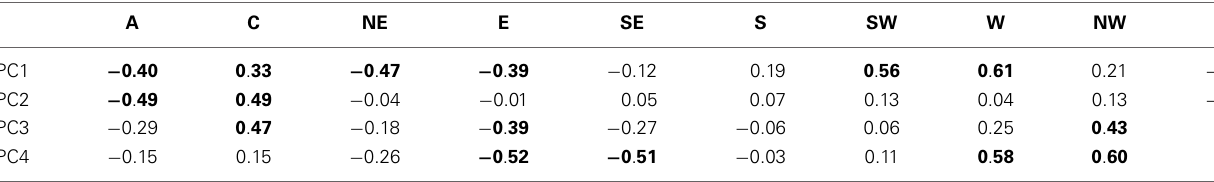
Bold values represent he correlations significant at 5% level.